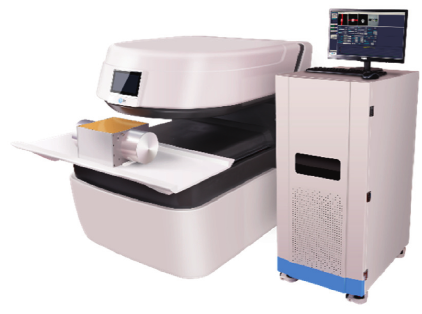
Figure 4: MacroMR12-150H-I